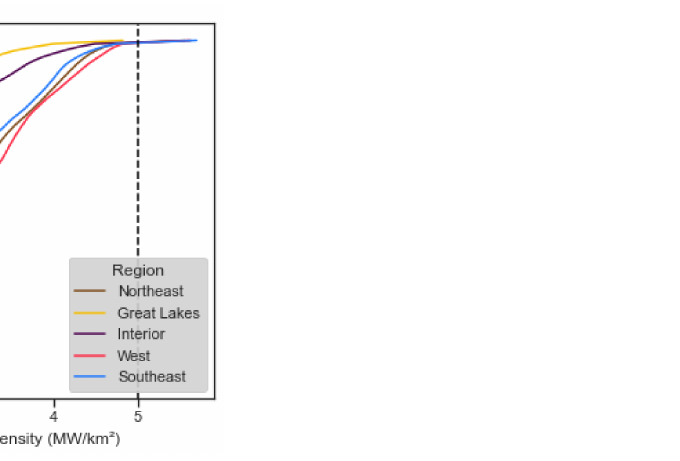
Figure 8. Cumulative distribution of predicted capacity density for major wind regions over non- excluded land areas. Dashed vertical lines refer to uniform capacity densities applied for estimates of U.S. wind power technical potential (3 MW/km 2 : Mai et al. [13]; 5 MW/km 2 : Lopez et al. [27]). See Lopez et al. [27] for definition of standard wind exclusions.